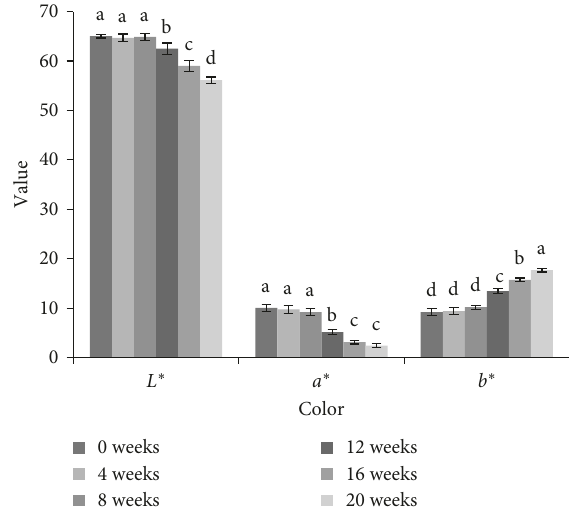
Figure 2: Changes in colors of the Basa fish fillet during frozen storage at − 20 ° C for 20 weeks. Bars represent standard deviation from triplicate determinations. The different letters on the bars within the same color indicate significant differences ( p < 0 .